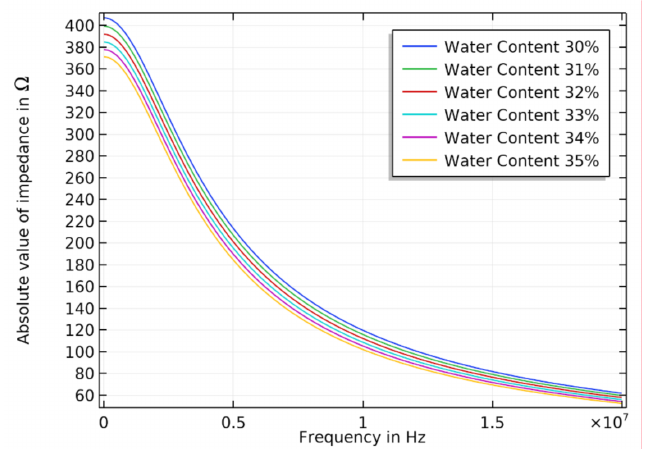
Figure 6. Simulation results of the absolute value of interdigital capacitor impedance as a function of frequency at different volumes of water